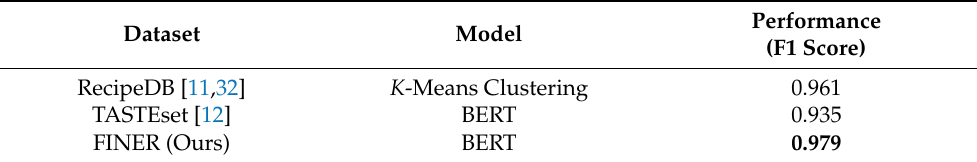
Table 10. Comparative analysis of the FINER dataset with other similar datasets from previous work with the best performance is emphasized in